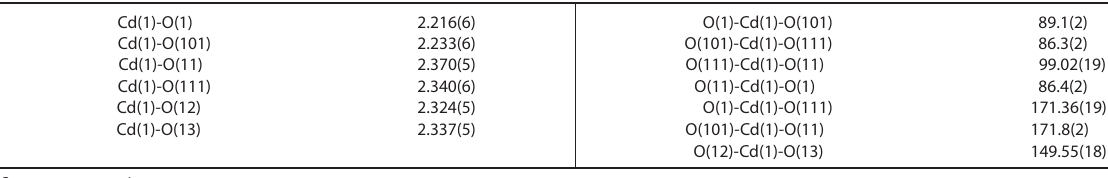
Table 2. Selected bond lengths (Å) and angles (°) for complex 1 .